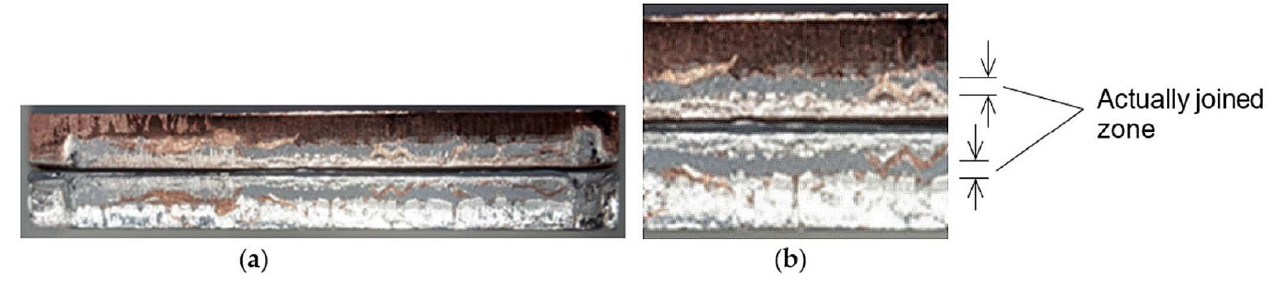
Figure 8. Example of joint boundary separated by bending (upper: C1100, lower: A6061, overlap length: 0.3 mm): ( a ) General view; ( b ) Magnified view.